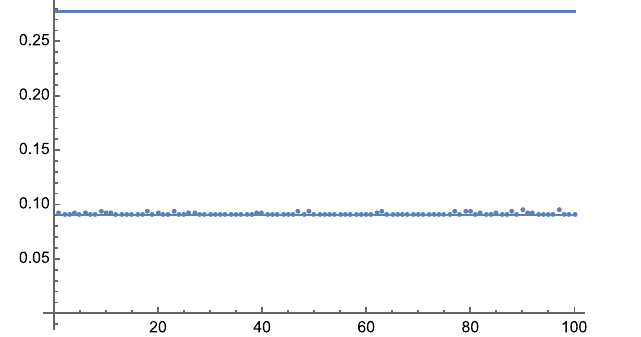
Fig. 10 The variances V [ F ] of Example 3 computed for 100 independent executions with the linear heuristic, using a total of 100 samples for each technique. The horizontal lines correspond to the optimal and the equal sampling budget variances,